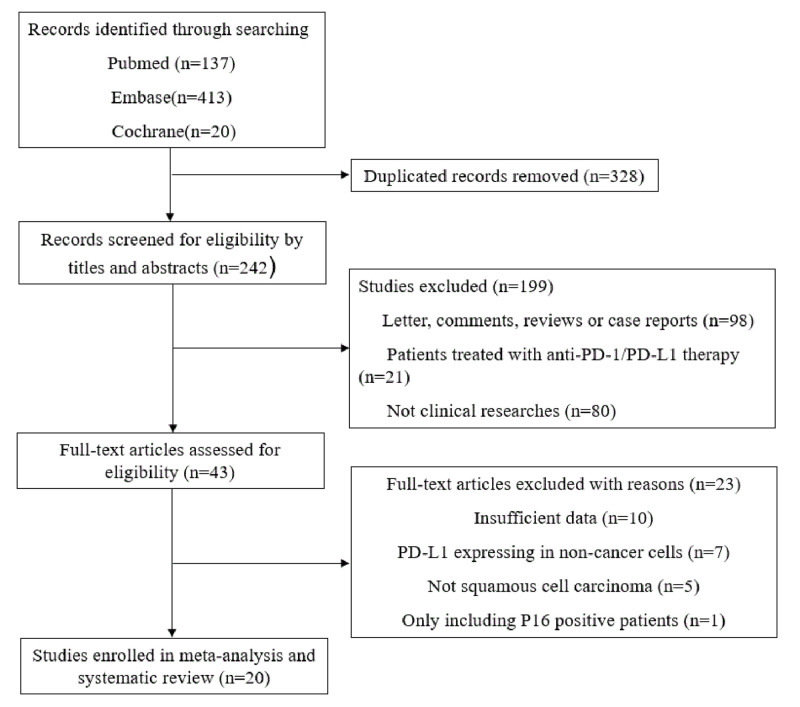
Study selection process